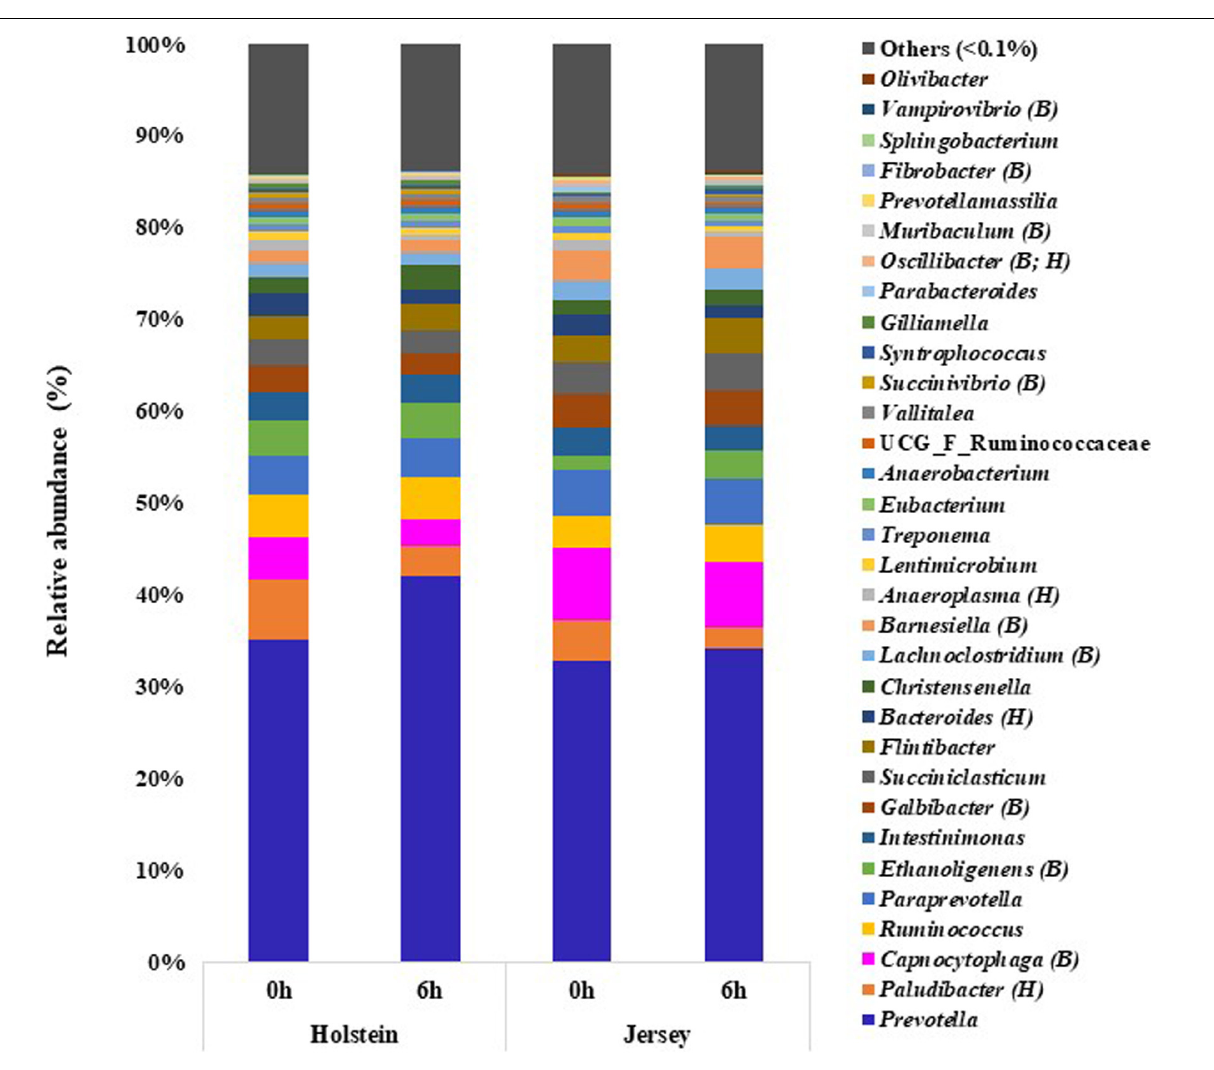
FIGURE 3 | Major genera (each having relative abundance ≥ 0.1%) of bacteria identified in the rumen of the Holstein and the Jersey steers. B and H indicate significant ( P < 0.05) differences in relative abundance between breeds and sampling hours,